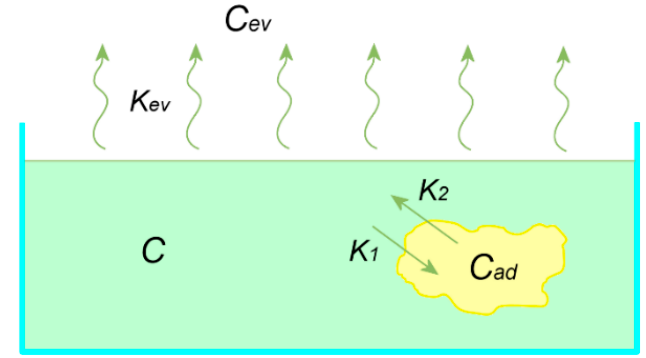
Figure 3. Schematization of BTX evaporation and adsorption mechanisms.